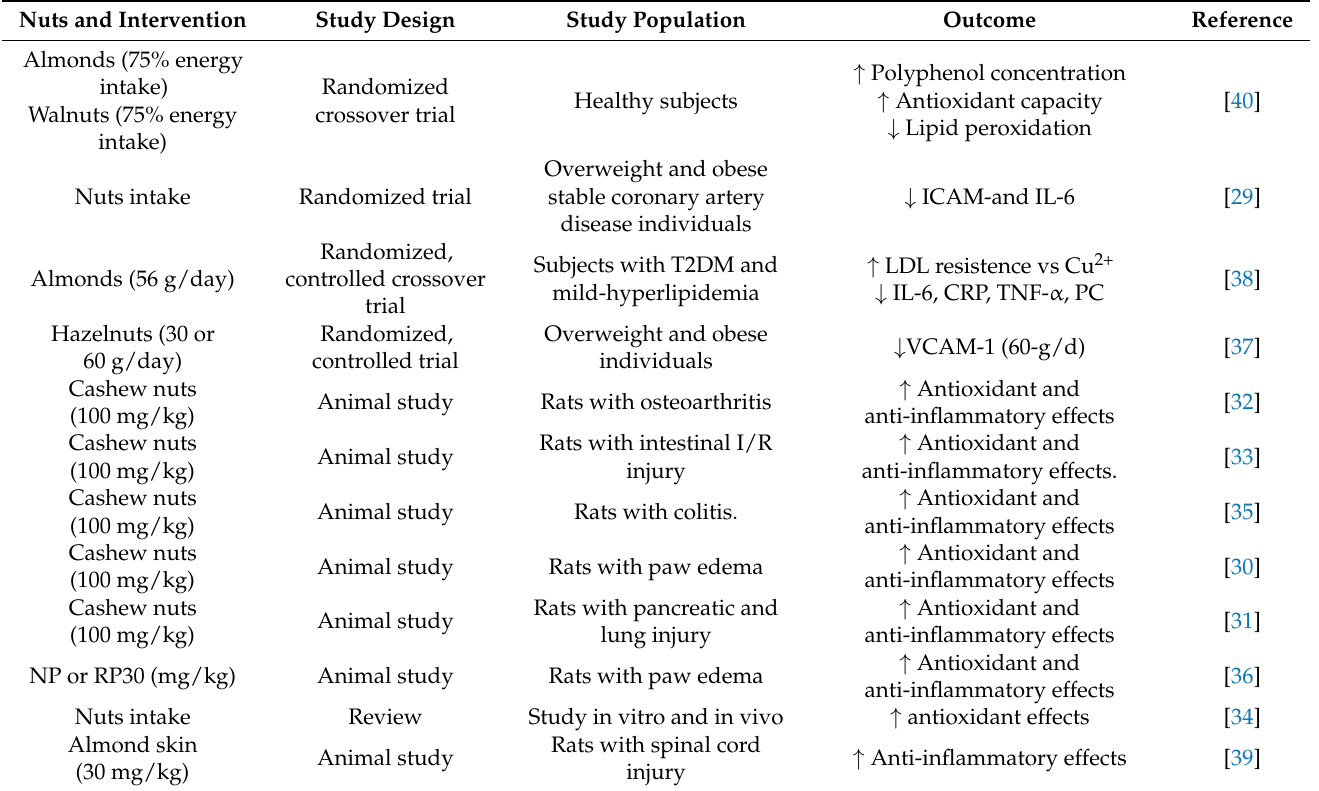
Table 4. Effect on inflammation and oxidative stress related to nut